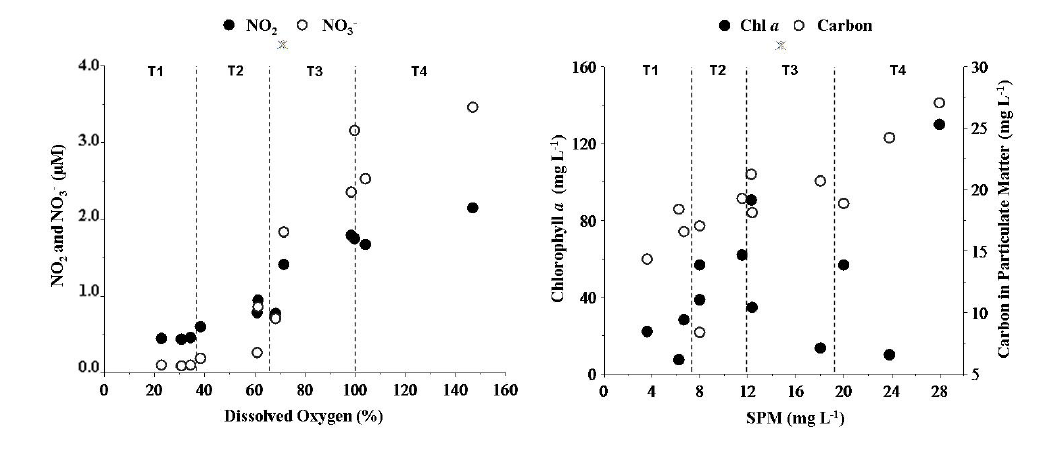
), nitrate (NO 3- ) with dissolved oxygen and 2